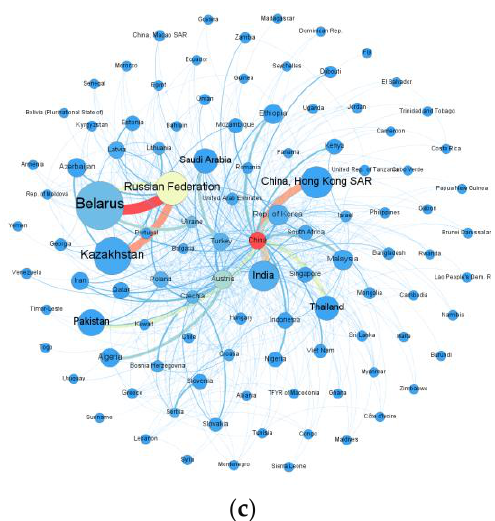
Figure A3. Trade networks of track fitting, signaling, and auxiliary traffic control equipment products in the BRI region. ( a ) phase 1 (2003–2008), ( b ) phase 2 (2009–2013), ( c ) phase 3 (2014–2017). The settings are the same as in Figure 7.